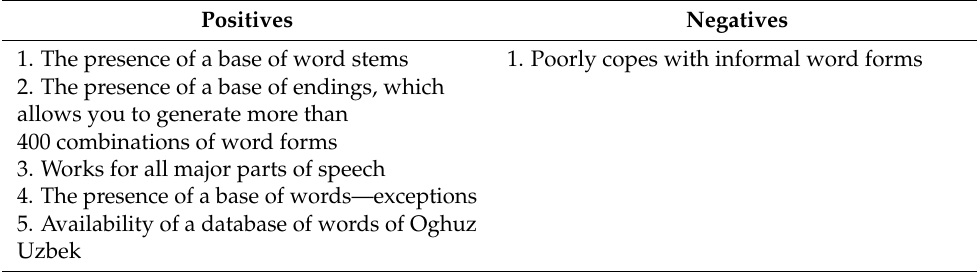
Table 3. Positive and negative aspects of UM